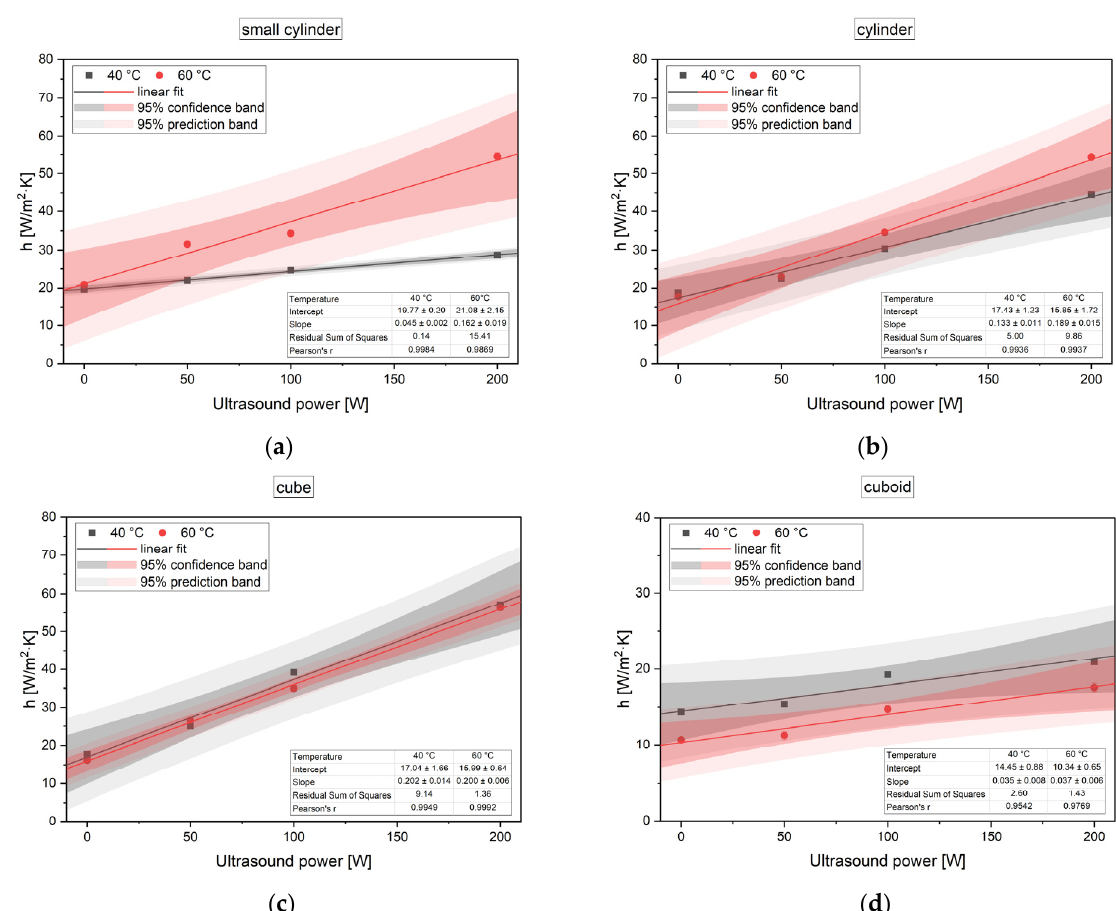
Figure 5. Heat transfer coefficients h versus applied ultrasound power P : ( a ) small cylindrical sample; ( b ) cylindrical sample; ( c ) cube; and ( d ) cuboid.